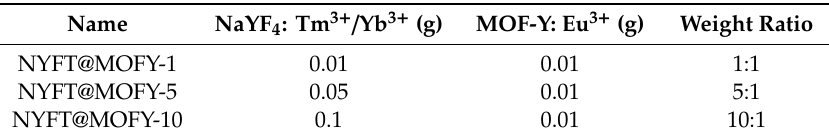
Table 1. Abbreviations of NaLnF 4 @MOF-Ln studied in this